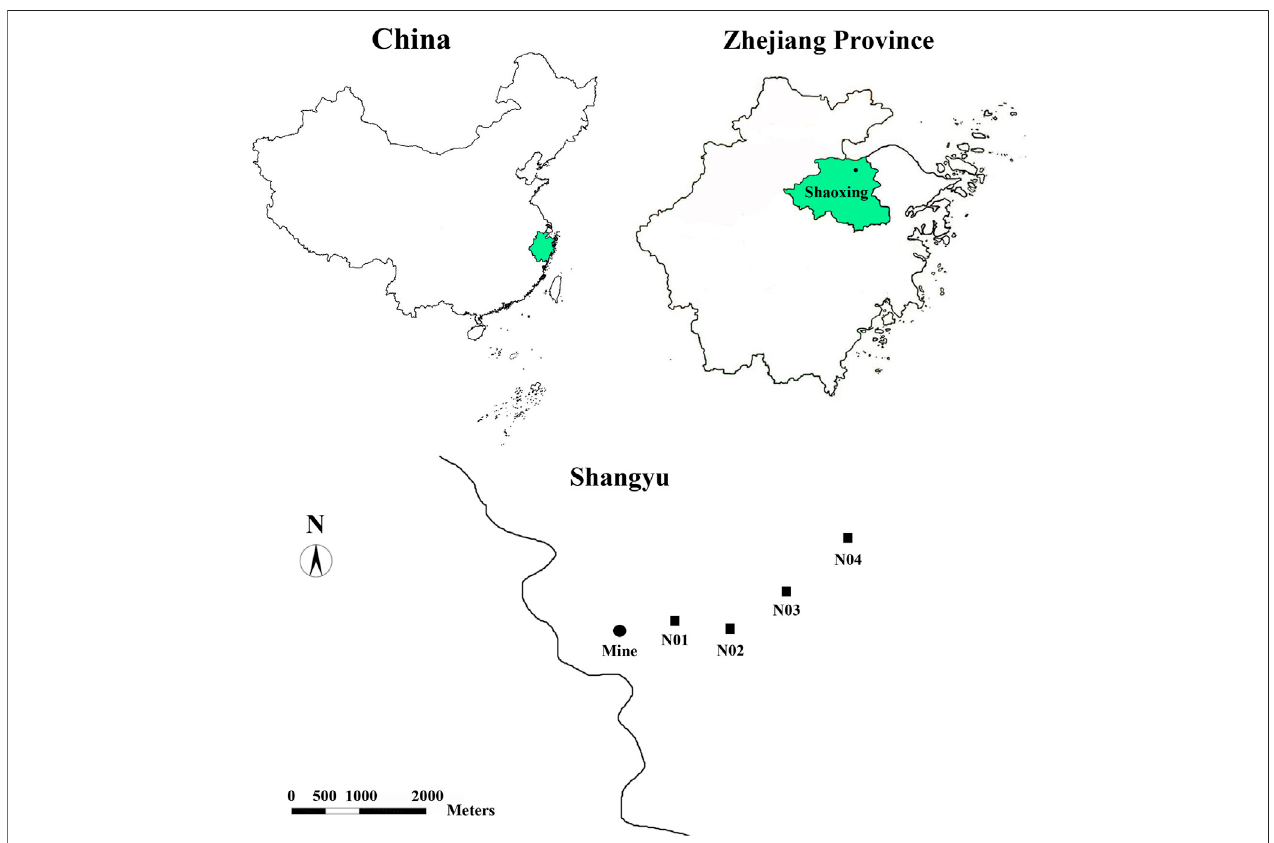
FIGURE 1 | Map of the study area and sampling locations in Shangyu mining